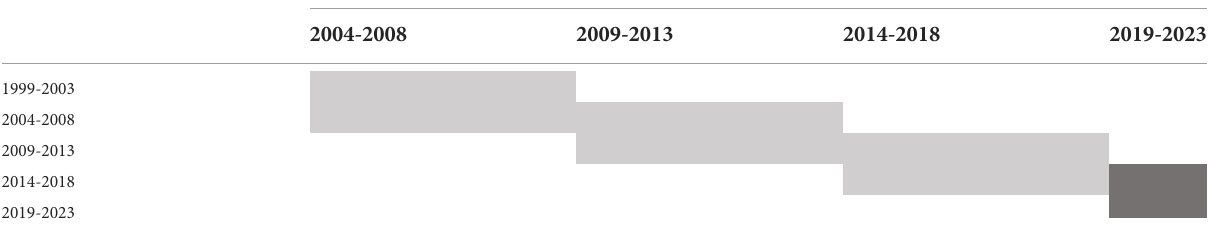
TABLE 1 Schematic diagram of the model-based period